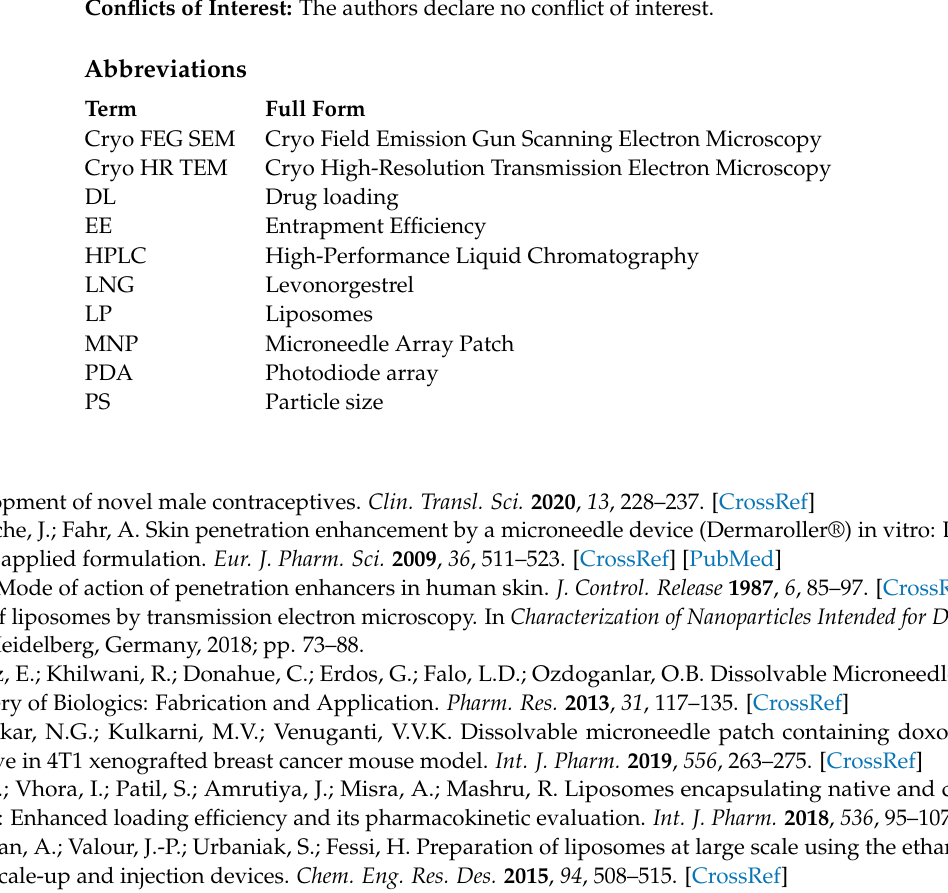
(Batch L6); Figure S2: Microscopy image of microneedle array patch loaded with rhodamine dye; Figure S3: Mechanical behavior of microneedle array under a compression force; Figure S4: Skin penetration study of microneedle array patch after insertion into the rat skin; Figure S5: Skin irritancy study after administration of